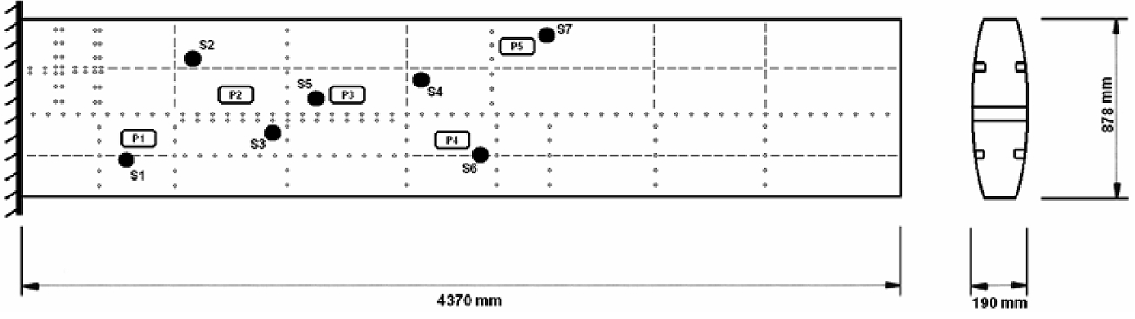
Fig. 2. Schematic of wing indicating locations of five inspection panels (P1-P5) and seven accelerometers